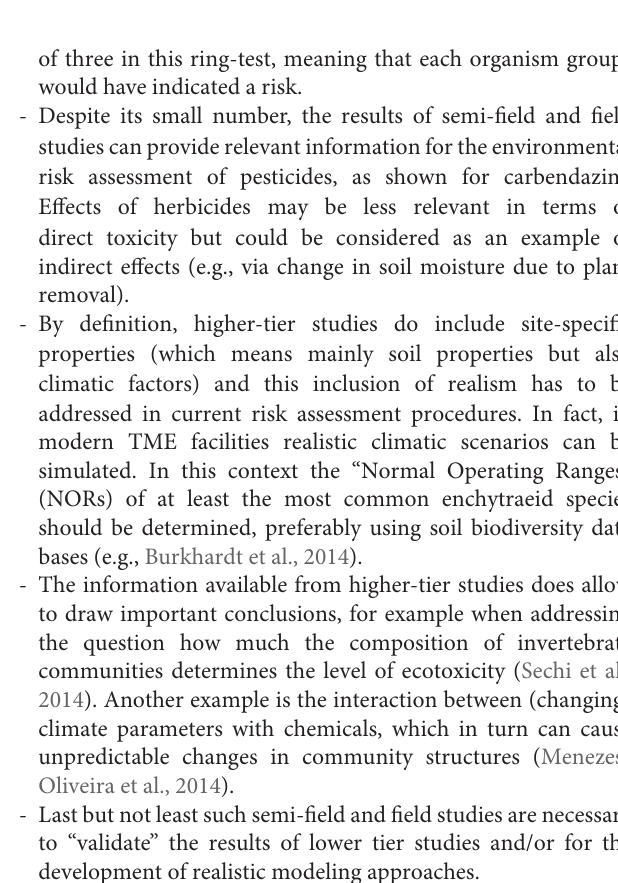
FIGURE 5 | Effects of two concentrations of the fungicide PCP (light gray dotted line: 0.5 kg/m 2 ; dark gray dotted line: 5 kg/m 2 ) on the enchytraeids of a beech wood forest (bimonthly application: 1982–1983; recovery time: 1984–1985) in percent of the control (solid darkline) (for details see Römbke, 2001